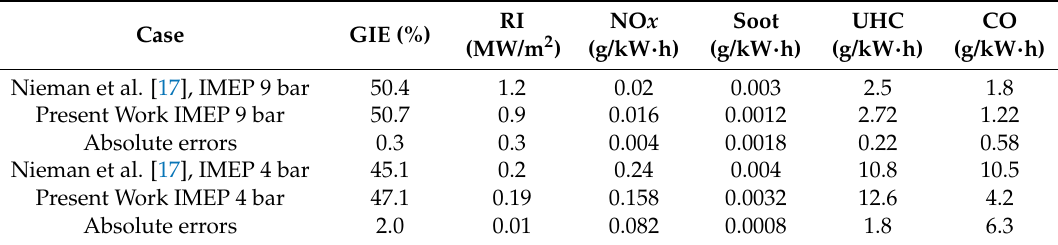
Figure 3. The validation cases pressure and heat release rate traces. Table 3. The validation cases emissions and